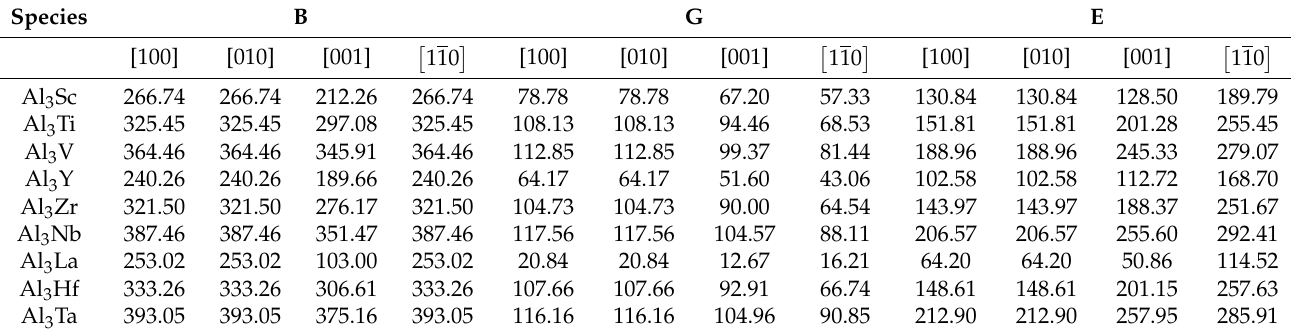
Table 5. The calculated uniaxial elastic moduli (GPa) in different directions of Al 3 TM compounds.